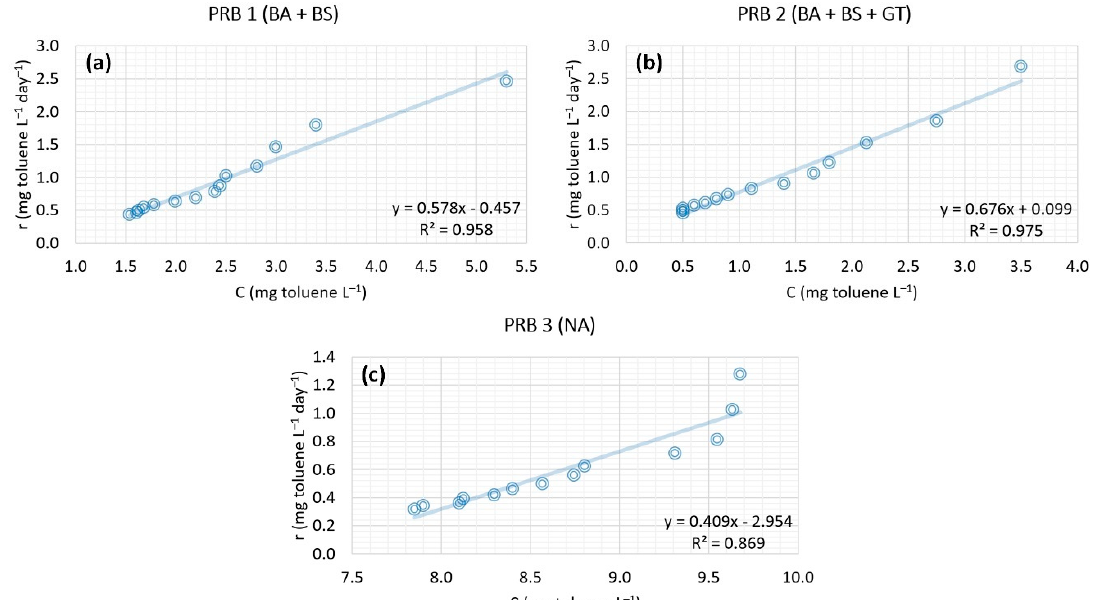
Figure 10. Reaction rate data for the PRB toluene treatment processes for phase 2: ( a ) The first-order model for PRB-1, ( b ) the first-order model for PRB-2, and ( c ) the first-order model for PRB-3.